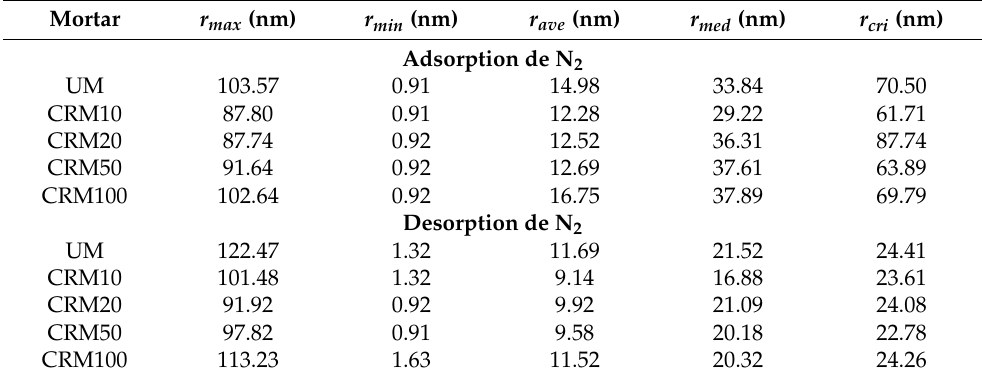
Table 6. Pore radius categories (N 2 adsorption and desorption